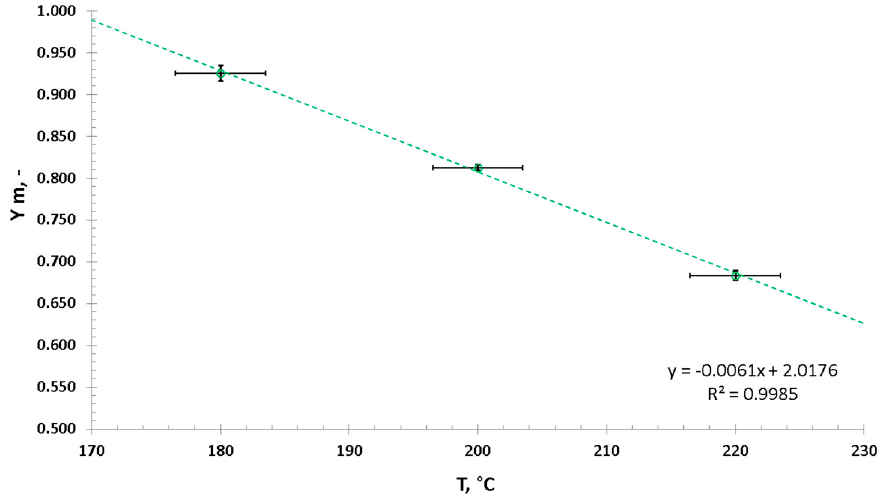
Figure 3. Mass yield for the performed HTC experiments.